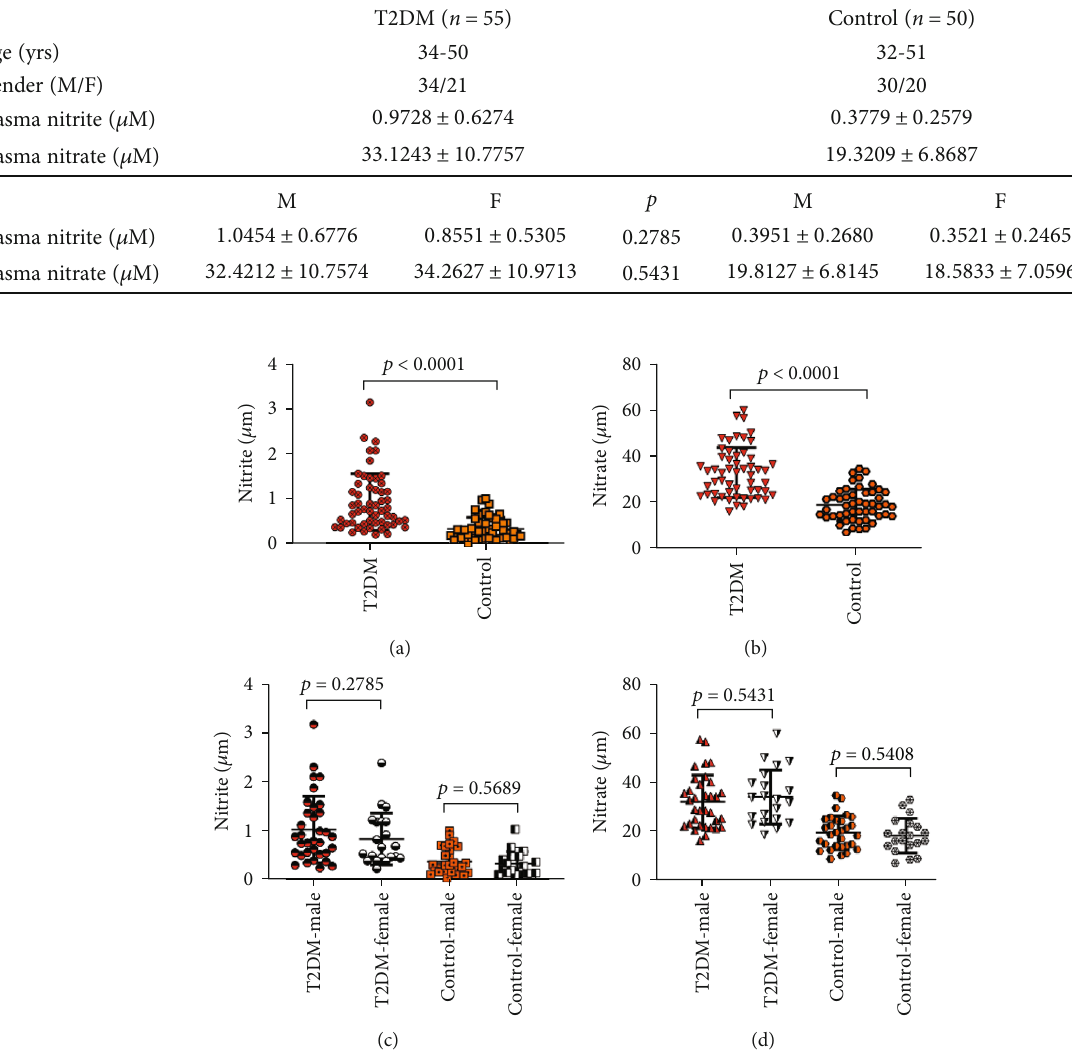
Figure 1: The nitrite and nitrate levels in plasma in the T2DM group and control group. Table 2: The TNF- α , IL-1 β , and IL-6 contents in insulin-stimulated HepG2